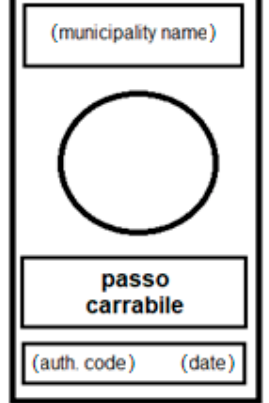
Figure 1. The pattern scheme of an Italian tow-away road sign.